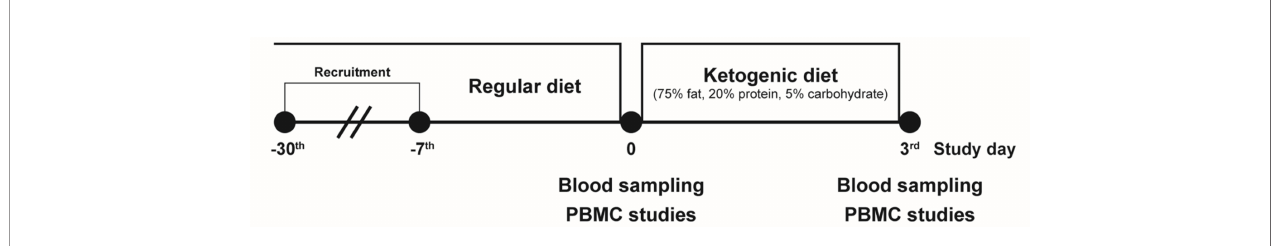
FIGURE 1 | Schematic of the isocaloric ketogenic diet protocol. Healthy volunteers were recruited, and blood samples were collected on day 0 and day 3 of isocaloric ketogenic diet. PBMC, peripheral blood